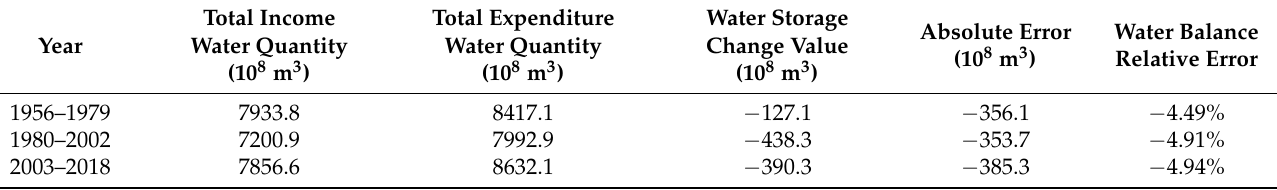
Table 5. Analysis of water balance in HRB from 1956 to